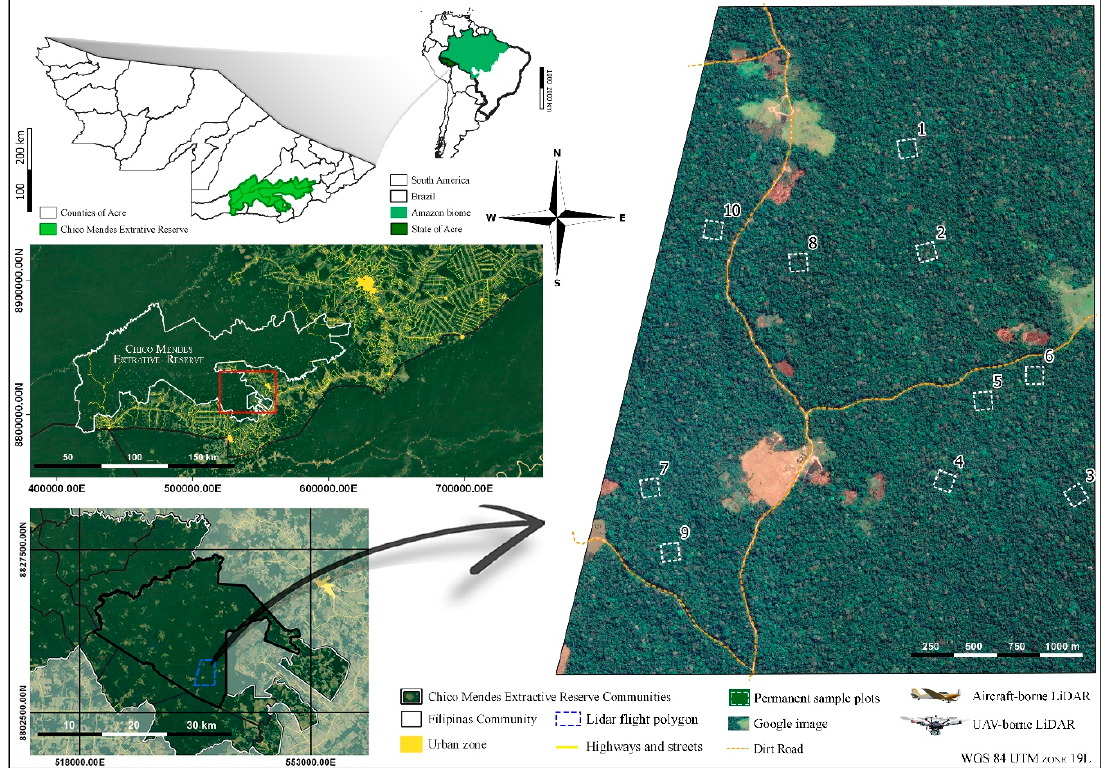
Figure 1. Map of Acre State and its location in South America (top left), the Resex Chico Mendes (middle and bottom left), the BR 317, and the surrounding urban areas (Brasileia and Epitaciolândia cities). The black polygon in the bottom left map is the Seringal Filipinas, and the blue polygon is the 1000 ha area covered by Light Detection And Ranging (LiDAR) flight in 2015. The Google map on the right represents the area covered by the 2015 LiDAR flight and the 15 established permanent sample plots (PSPs).